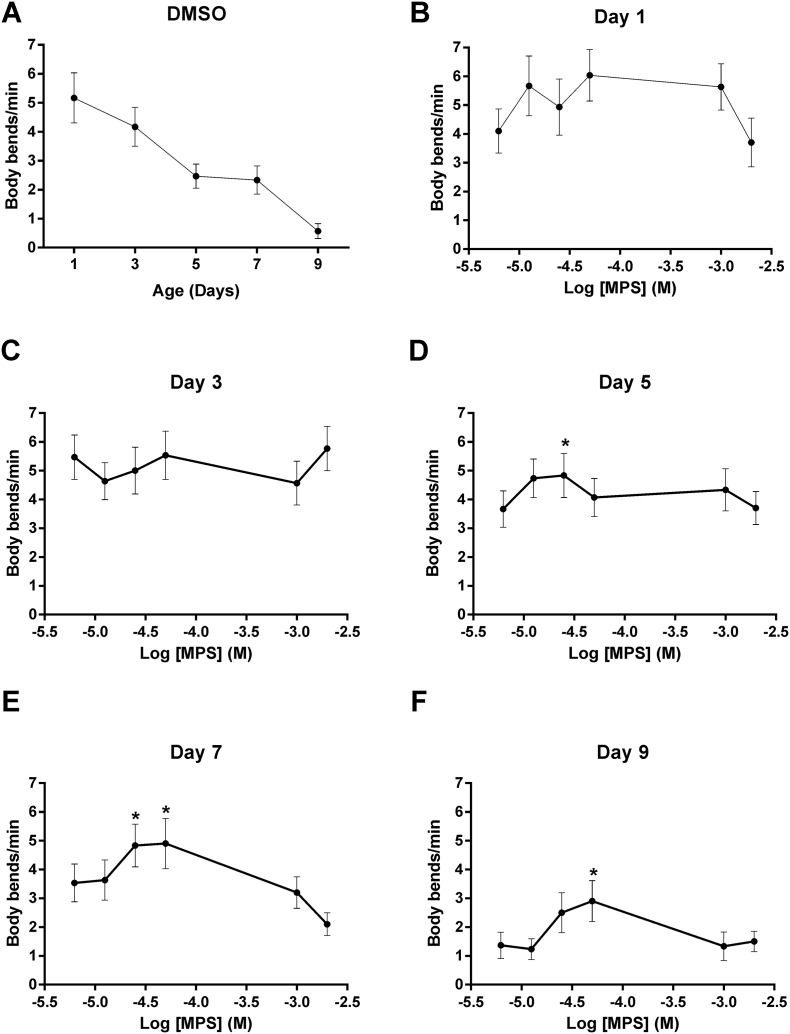
MPS concentration-response relationship using a worm TDP-43 proteinopathy model. Body bend frequencies of chronically-treated, age-synchronised TDP-43(A315T)-expressing worms were assessed to determine the concentration-response relationship of the compound at various ages of adulthood. (A) Body bends of control worms treated with the 0.4% DMSO vehicle at all ages. Although control values were not incorporated into concentration-response curves on the logarithmic scale as a logarithmic value cannot be obtained for 0 M of the compound, body bend frequencies for each day were compared against respective control values for statistical analysis. Locomotion defects were not ameliorated at any concentration on (B) days 1 and (C) 3 (p > .05). (D - F) At older ages, locomotion rate was significantly improved at concentrations of −4.6 M (0.025 mM) and −4.3 M (0.05 mM) (p < .05), although higher concentrations reduced it instead. Data shown was pooled from three biological replicates, and comparisons were made with the Kruskal-Wallis test with Dunn's multiple comparisons (n = 30 worms per day per concentration); *, p < .05.